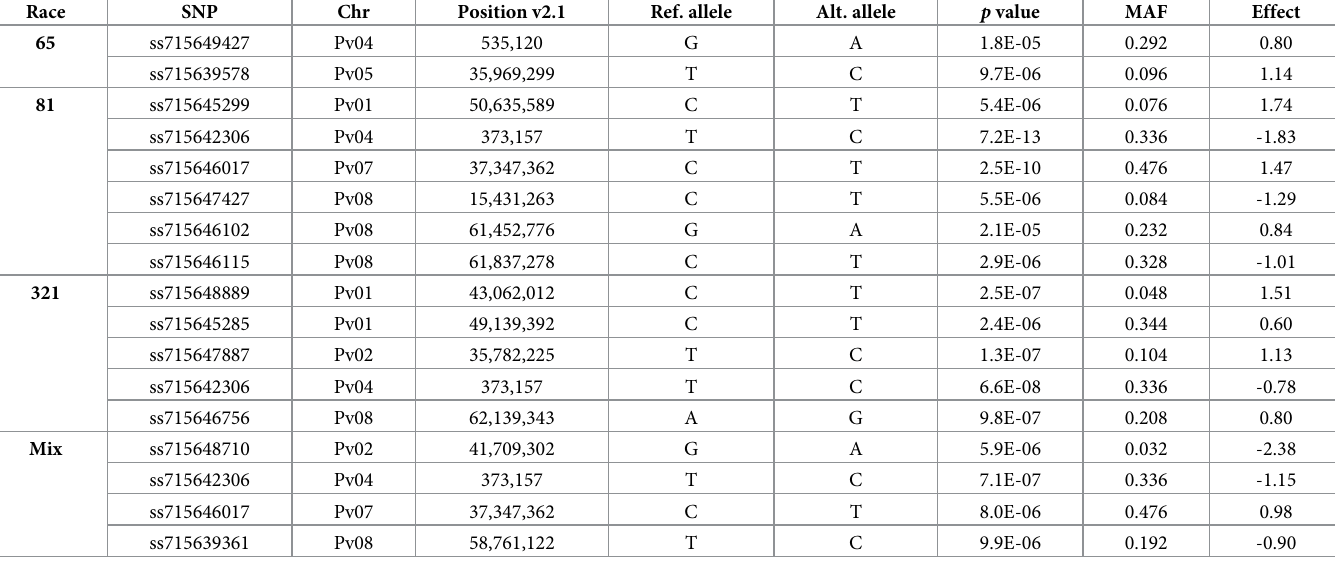
Table 1. Genome-wide association study results for the association between phenotypic evaluation of the carioca diversity panel (CDP) with multiple races of anthracnose and the high-throughput genotyping. Race